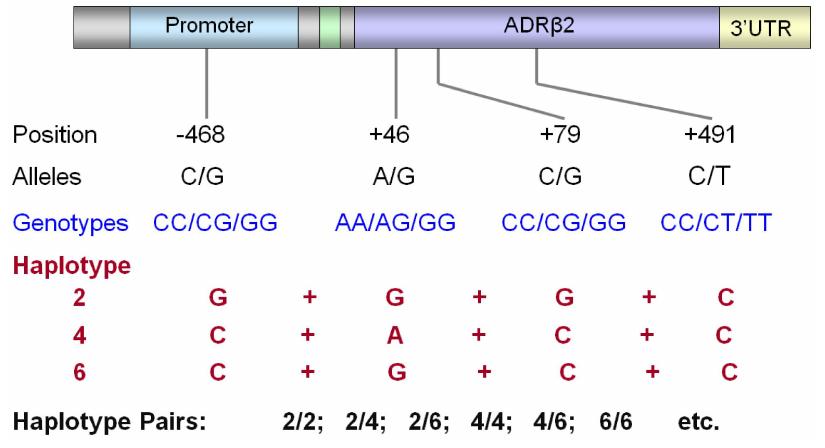
Figure 1. Schematic representation of ADR b 2 genotype, haplotype and haplotype pair.